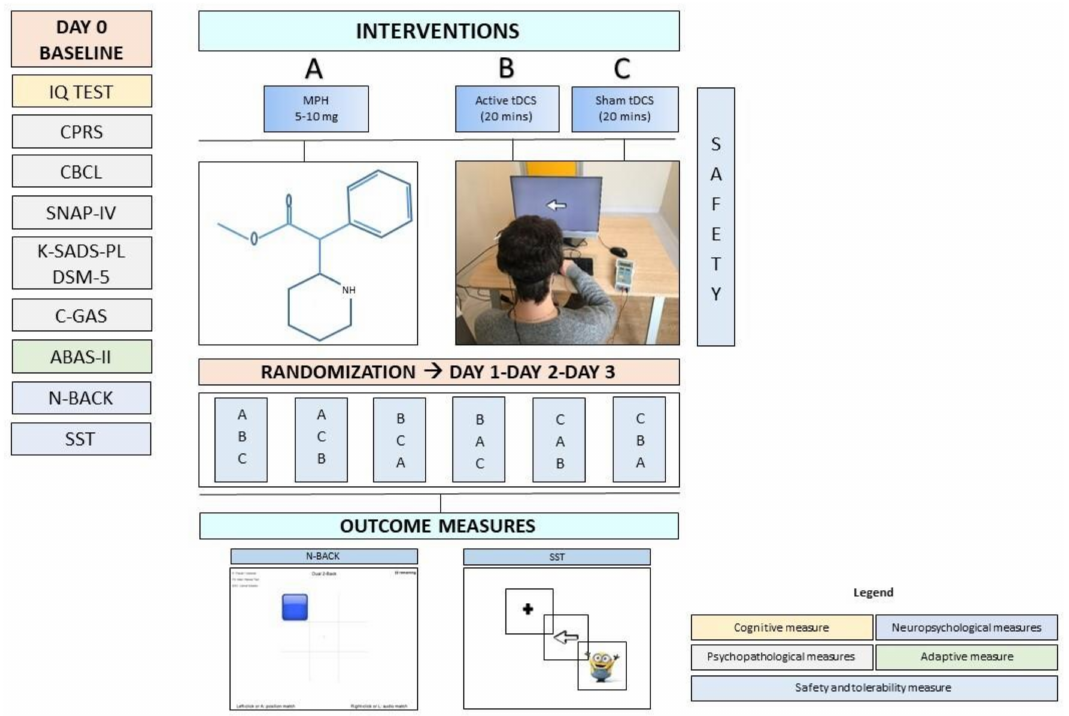
Figure 1. Overview of the study design. DAY 0, Baseline; DAY 1, DAY 2, DAY 3, Day of conditions administration; ( A ) single shot of active tDCS session; ( B ) single shot of sham tDCS session; ( C ) single dose of MPH (Ritalin ® ); CBCL, Child Behavior Checklist; CPRS, Conners’ Rating Scales; SNAP-IV; K-SADS-PL DSM-5, Kiddie Schedule for Affective Disorders and Schizophrenia Present and Lifetime Version for DSM-5; C-GAS, Children Global Assessment Scale (questionnaire from the K-SADS-PL DSM-5); ABAS-II, Adaptive Behavior Assessment System; N-Back; SST, Stop Signal Task; Safety and Tolerability